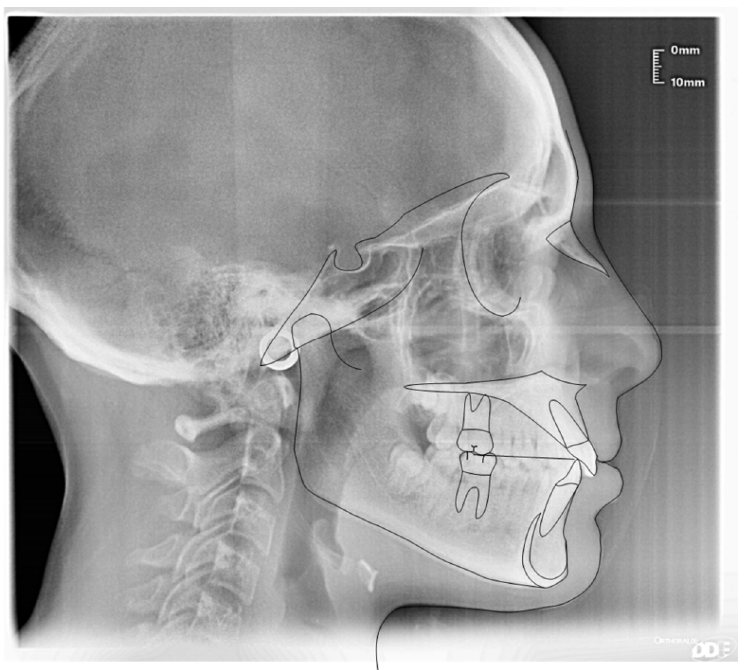
Figure 11. Cephalometric tracing (DeltaDent software) after treatment and a 3-year follow-up period (14-year-old). Table 2. Cephalometric analysis after treatment and a 3-year follow-up period.